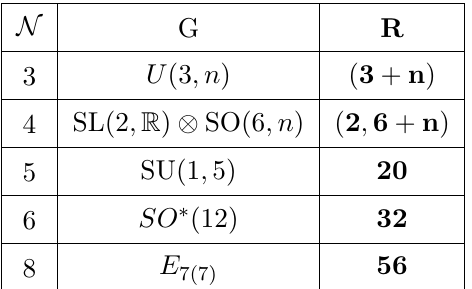
> 3 supergravity sequence of groups Table 2 . N their symplectic representations R . Note that in the case of yet it is anomalous.